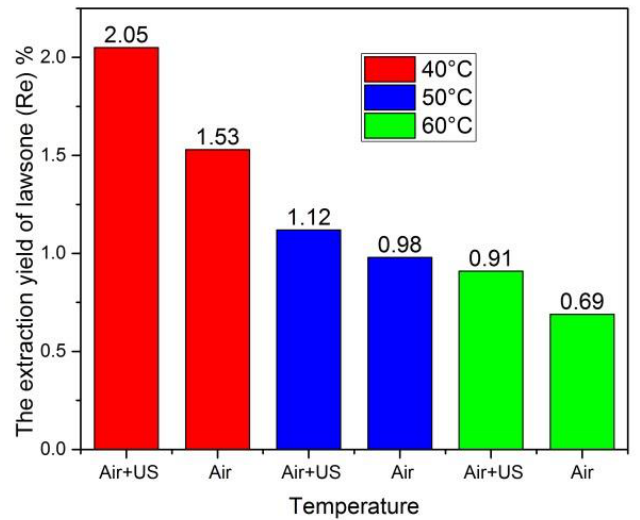
Figure 6. The extraction yield of lawsone extracted from henna leaves at 40, 50 and 60 °C without (Air) and with (Air + us; 20.5 kW/m 3 ; 21.7 kHz) ultrasound application.